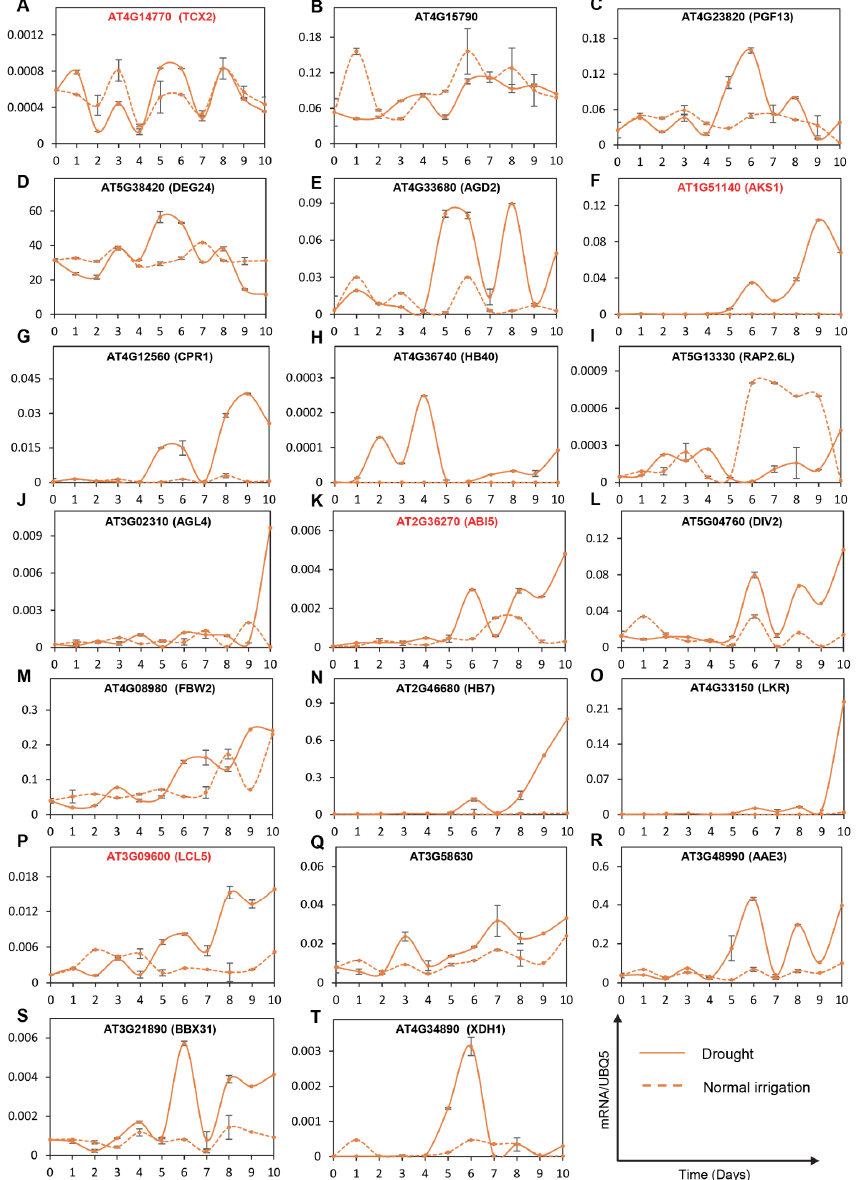
Figure 5. Kinetics of gene expression of transcription factors (red) and their targets in Col-0 under drought (solid lines) and normal irrigation (dotted lines) conditions. RT-qPCR was performed in leaf samples collected daily from day 0 to day 10. Gene expression was assessed using reference gene UBQ5 in four groups: TF1 (AAT4G14770 and targets ( B ) AT4G15790, ( C ) AT4G23820, ( D ) AT5G38420, ( E ) AT4G33680; TF2 ( F ) AT1G51140 and targets ( G ) AT4G12560, ( H ) AT4G36740, ( I ) AT5G13330, ( J ) AT3G02310; TF3 ( K ) AT2G36270 and targets ( L ) AT5G04760, ( M ) AT4G08980, ( N ) AT2G46680, ( O ) AT4G33150; TF4 ( P ) AT3G09600 and targets ( Q ) AT3G58630, ( R ) AT3G48990, ( S ) AT3G21890, ( T ) AT4G34890. The graphs represent the mean with standard errors of three technical replicates. Experiments were performed in three biological replications. The gray lines indicate error bars computed as the standard